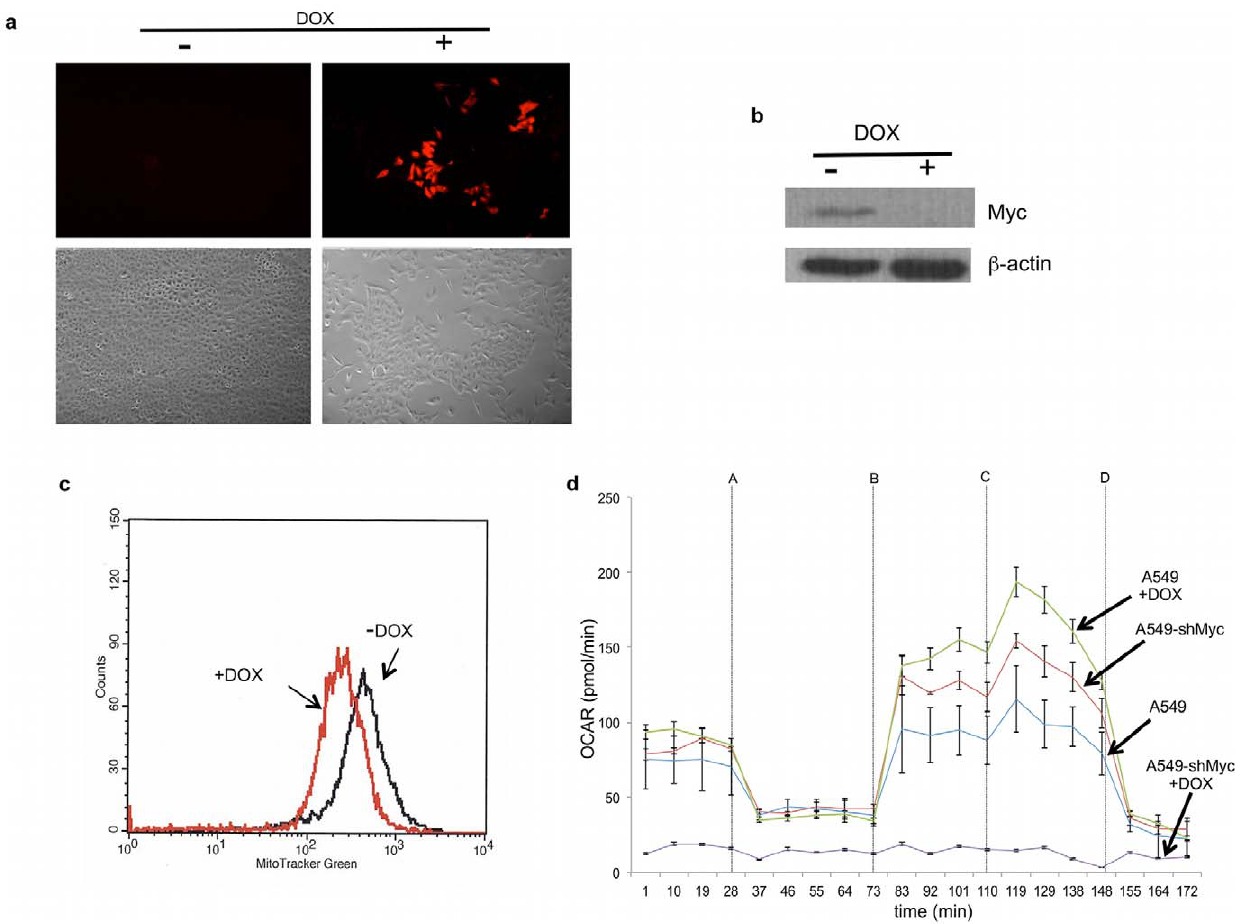
Figure 4. Mitochondrial structure and function in human A549 cells. ( a ) Effect of Myc shRNA induction . A549 cells expressing doxycycline (DOX)-inducible Myc shRNA were exposed to DOX for 4 days after being grown to 50–75% confluency. The upper right panel shows the signal from the co-expressed RFP. The upper left panel shows the same cells grown in the absence of DOX. The lower panels represent changes in growth as a result of DOX exposure following the plating of equal numbers of cells and a subsequent four day period of growth + / 2 4-HT. ( b ) Endogenous Myc protein levels . Immunoblotting for Myc protein in control, non-DOX-treated cells or those exposed to DOX for four days. b -actin was used as a loading control. ( c ) Mitochondrial mass . Cells were exposed to DOX for four days and stained with MitoTracker Green. ( d ) OXPHOS. A typical experiment as performed on the Seahorse is shown for cells grown in the presence and absence of DOX for four days. Included are control A549 transduced with a lentiviral vector expressing a scrambled shRNA sequence and which do not display any changes in OXPHOS when exposed to